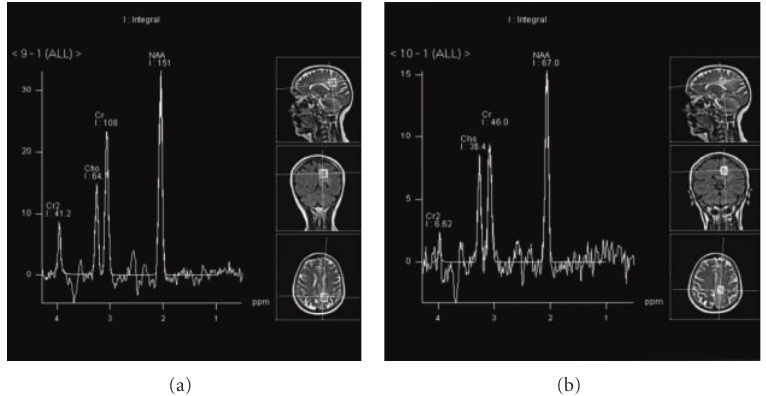
Figure 3: MRS SV spectrum from abnormal signal brain area (Figures 3(a) and 3(b)) showing NAA and Choline levels within normal limits.